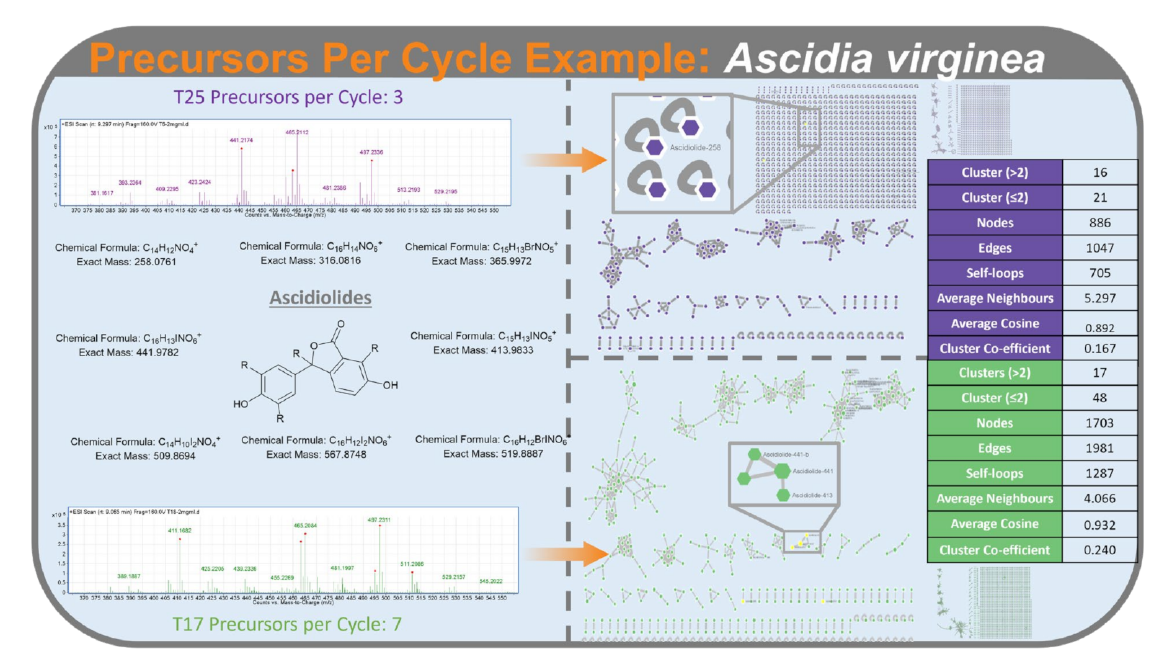
Figure 6. An example of the effects of PPC on molecular networking responses, of a Feature-Based Molecular Network for Ascidia virginea . MS spectra with ions selected form MS 2 fragmentation denoted with a red dot for precursor per cycle of 3 (top, purple, T25) and 7 (bottom, green, T17). Molecular networks produced from these parameters are displayed on the right, with tables display- ing molecular network statistics. Eight ascidiolides were annotated with T17 molecular network (7 precursors per cycle) and three ascidiolides were annotated in T25 molecular network (3 precursors per cycle).